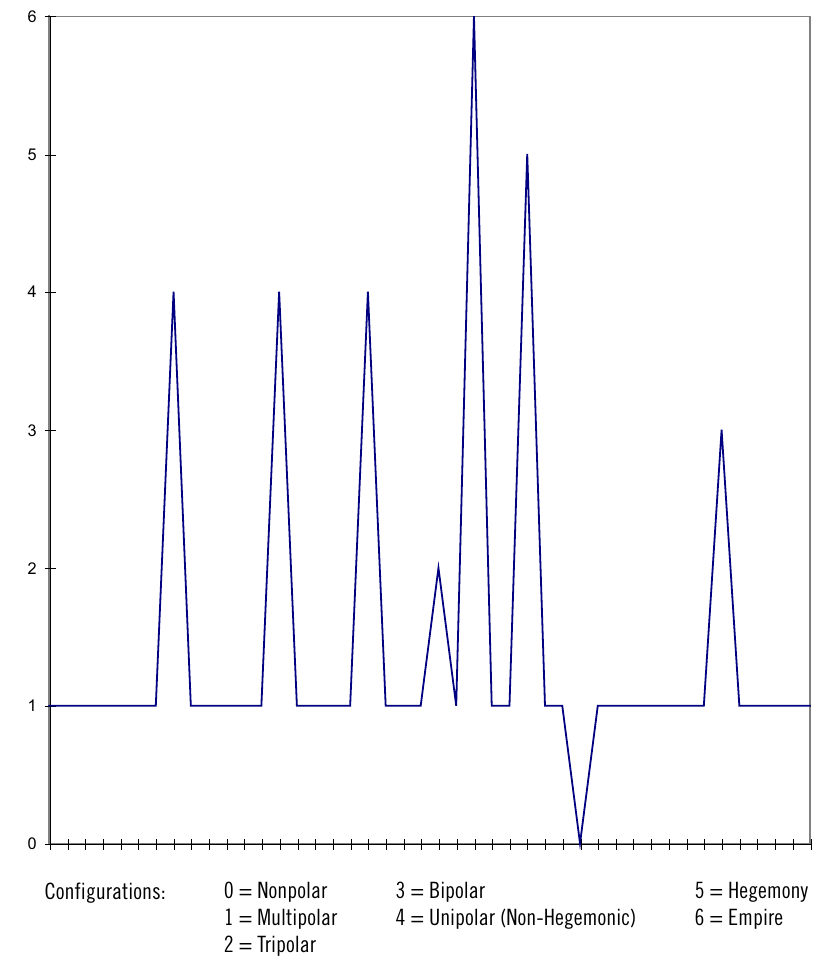
Figure 15 – Multipolar